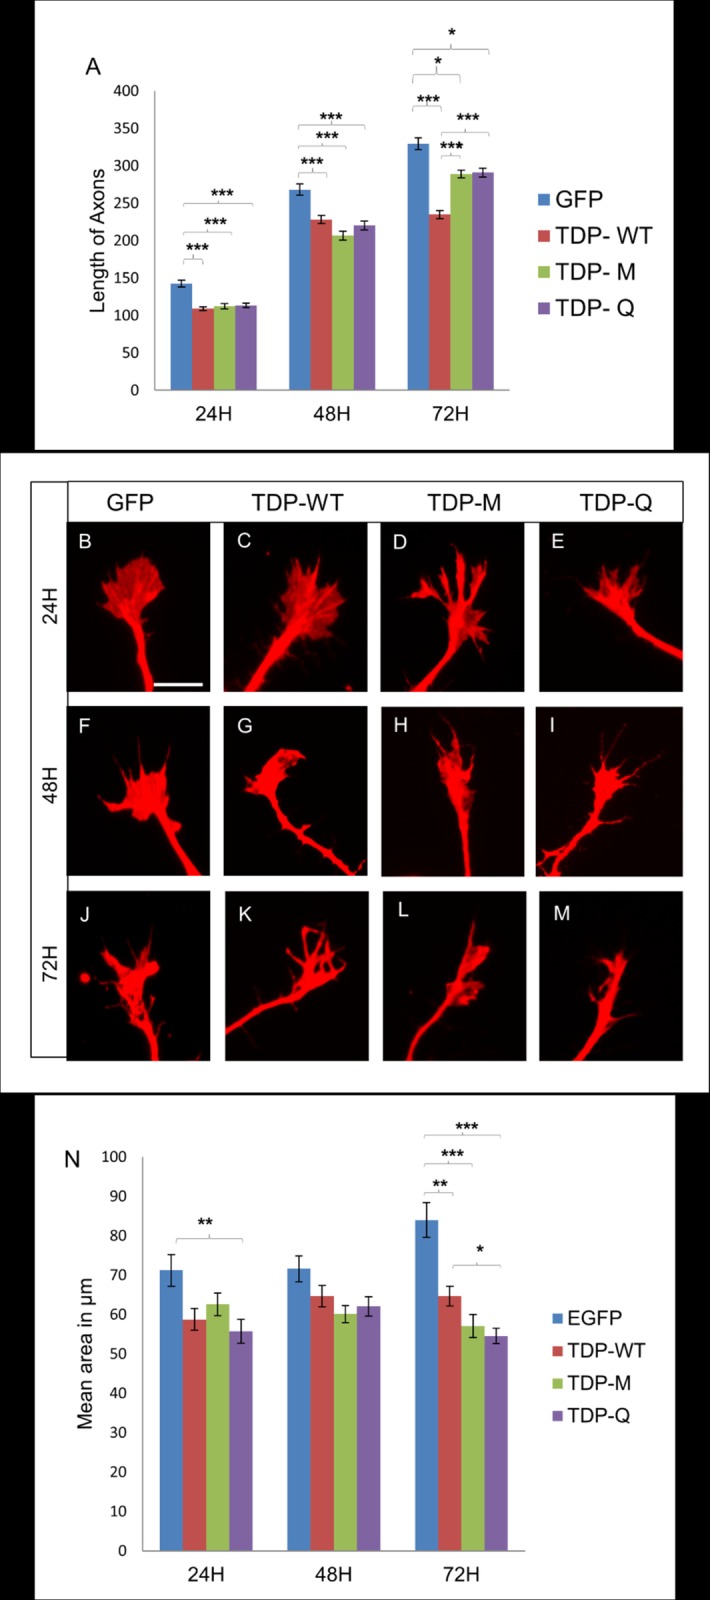
TDP-43 affects axonal growth in vitro.(A) Quantitation of axon lengths of transfected neurons at time-points as labelled (n = 3 experiments; 100 neurons per experiment). Data is presented as means and standard errors. Significance were compared by ANOVA between constructs at same time points (no significance—p > 0.05; * P < 0.01; ** P < 0.001; *** P < 0.0001). (B)–(M) typical cortical neuron growth cones stained with anti-tyrosinated tubulin antibodies at timepoints and with constructs as labelled. Scale bar = 10 µm. (N) Quantitation of mean growth cone area at 3 different time points as labelled (70 neurons per construct per experiment, 3 experiments). Data is presented as mean and standard error. Significance denoted as for (A).